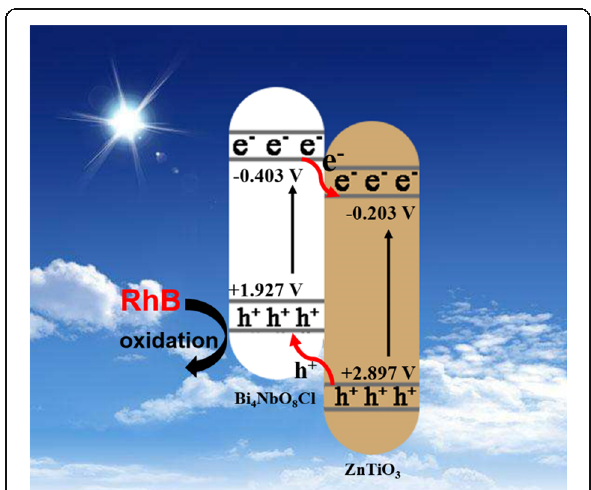
Scheme 1 Schematic diagram of the proposed mechanism for